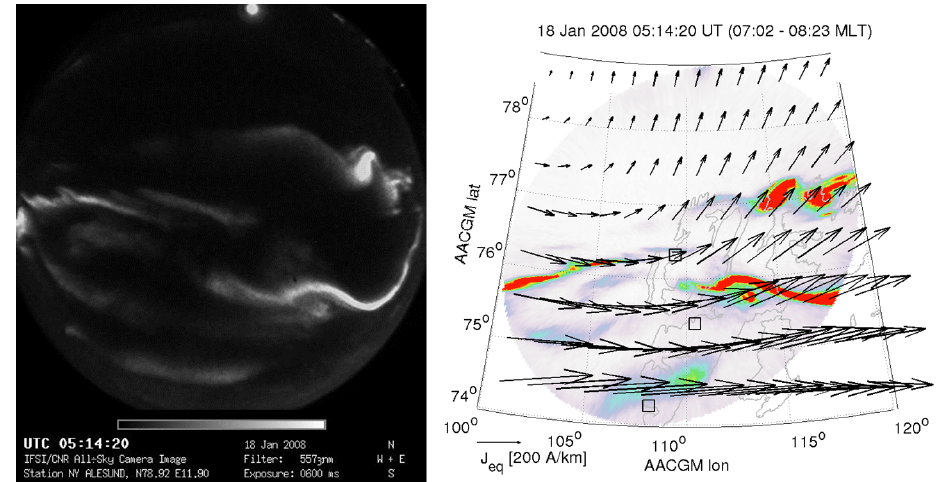
Figure 7. (left) All-sky camera image from the NAL station (557.7nm) on 18 January 2008, at 05:14:20UT and (right) its projection on a map (altitude 110km assumed) together with some equivalent current